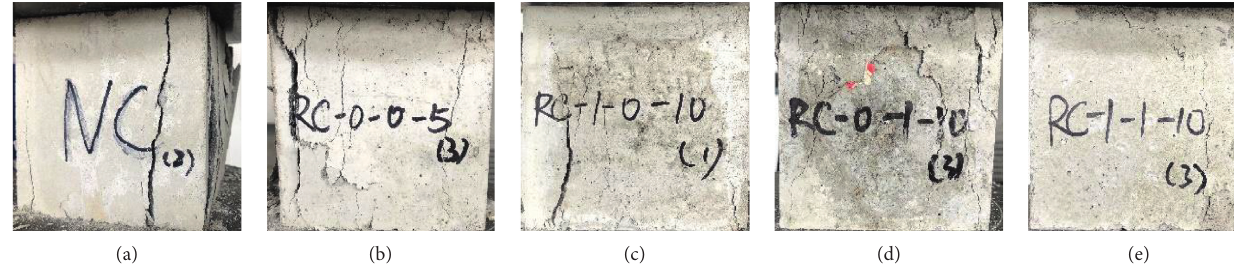
Figure 9: Typical failure forms of concrete. (a) NC. (b) RC-0-0-5. (c) RC-1-0-10. (d) RC-0-1-10. (e) RC-1-1-10.